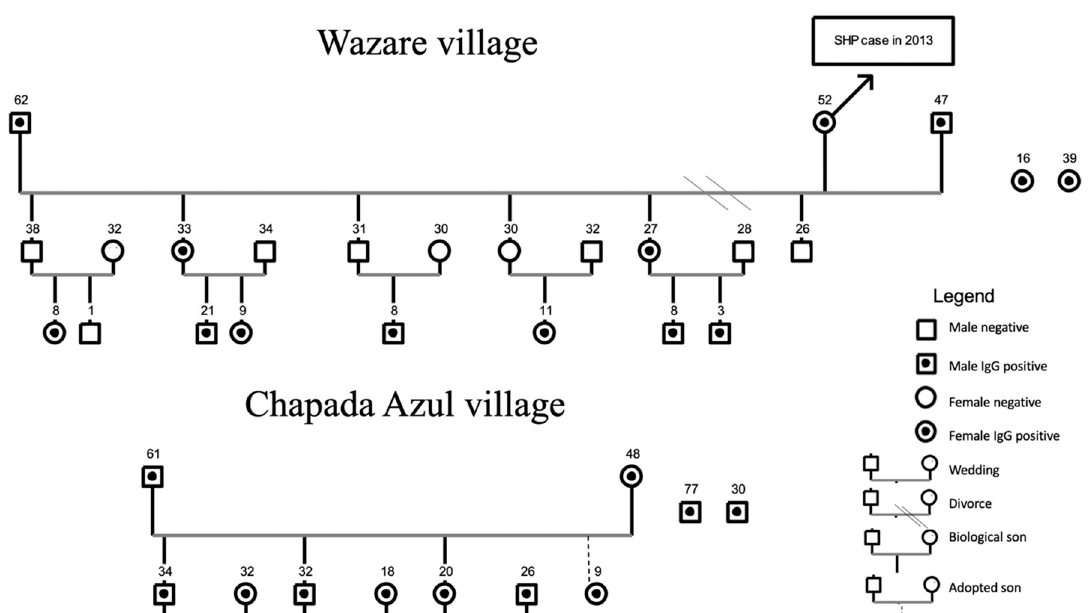
Figure 1. Geographical location of Mato Grosso Indigenous lands, highlighting Utiariti Indigenous land and nine villages of the Haliti-Paresí community in the southeastern region of the Brazilian Amazon, 2014–2015.